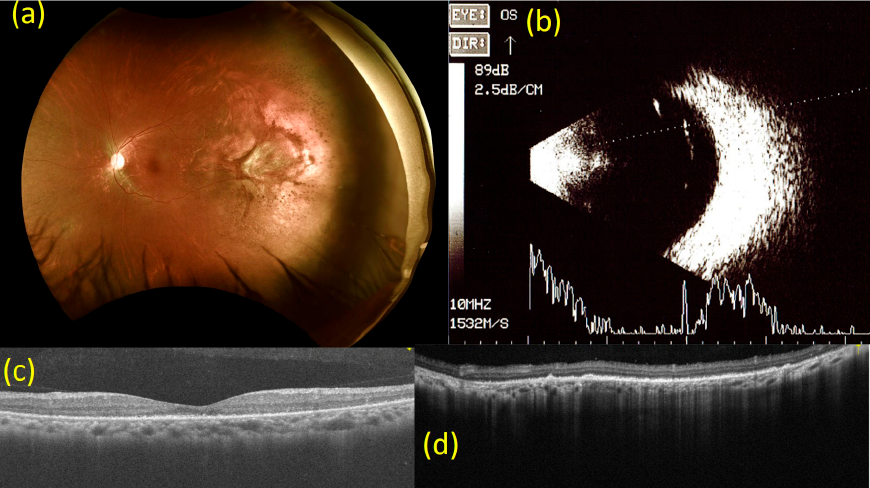
Figure 4. Images from 6 months after the injection of bevacizumab (2.5 mg). ( a ) Fundoscopy 6 months after the injection of bevacizumab (2.5 mg). Findings are consistent with imaging done at 6-week follow-up. ( b ) B-mode ultrasonography 6 months after the injection of bevacizumab (2.5 mg). The tumor in the left eye has almost disappeared and its size is too small to quantify. ( c ) Macular optical coherence tomography (OCT) scan 6 months after the injection of bevacizumab (2.5 mg). Findings are consistent with imaging done at a 6-week follow-up for the left eye. ( d ) OCT scan of the choroidal mass at the 2 to 3 o’clock position on the peripheral side in the left eye 6 months after the injection of bevacizumab (2.5 mg). Findings are consistent with the imaging conducted at 6-week follow-up.